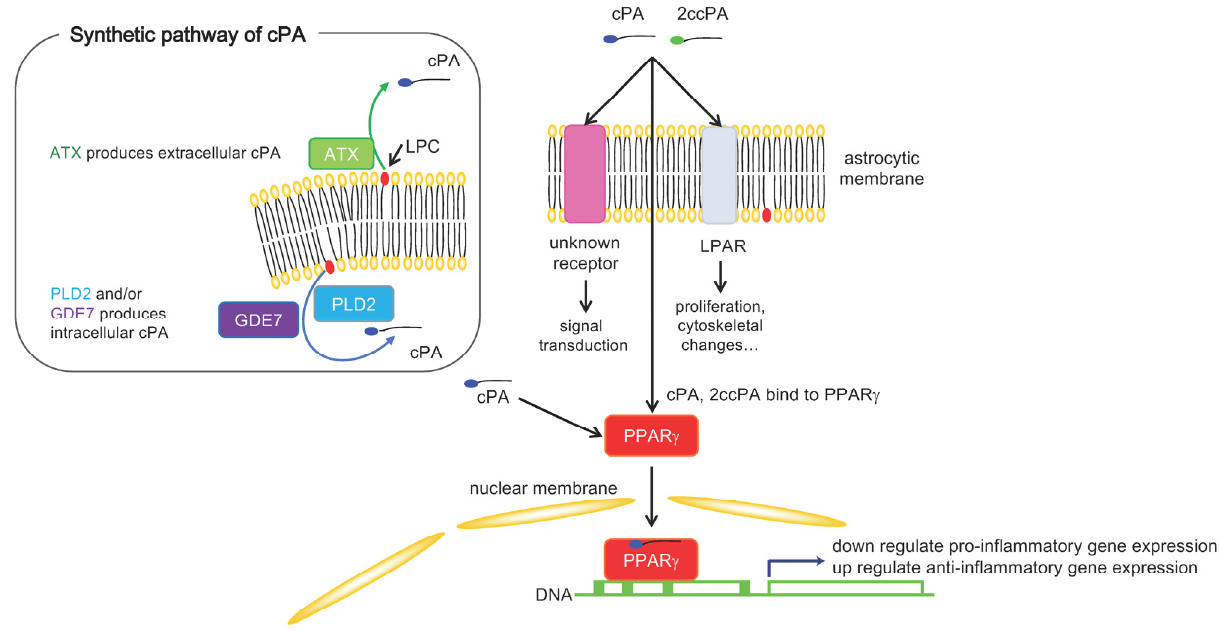
Figure 2. Hypothesis to explain the effect of cPA on the astrocyte immune response. cPA in the brain is produced by intracellular or extracellular enzymes [121,130,131]. Extracellular cPA stimulates six different LPARs [126] and induces cellular responses, including cell proliferation and cytoskeletal changes [140]. The intracellular and/or extracellular cPA bind PPAR- γ and induce anti-inflammatory responses [130,141]. cPA also binds ANT2, and this binding is related to protecting cells from apoptotic death [142]. There may be unknown cPA-specific receptors. (This figure adapted from Ref.